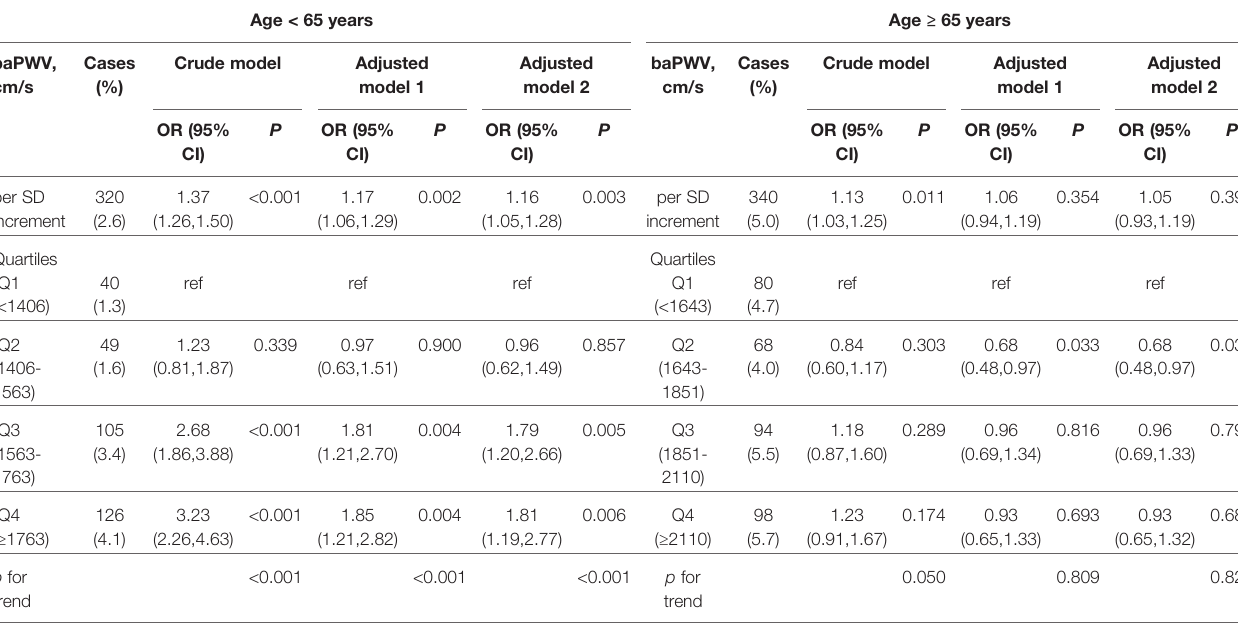
TABLE 2 | The association between baseline brachial ankle pulse wave velocity (baPWV) and risk of fi rst stroke in various age groups. baPWV, cm/s